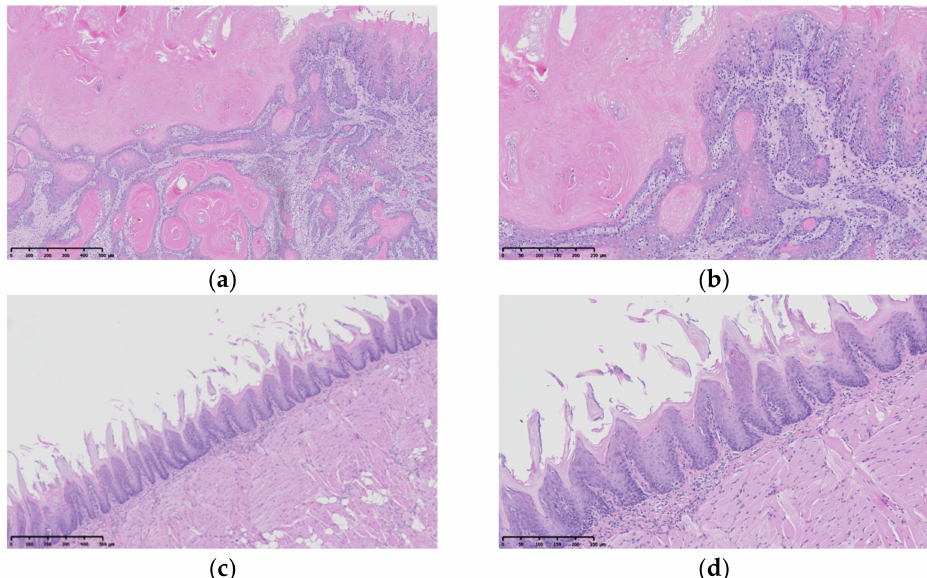
Figure 9. Histopathological assessments of tongues following H&E staining: ( a ) CTRL group (Mic. Mag.; × 100); ( b ) CTRL group (Mic. Mag.; × 200); ( c ) Film group (Mic. Mag.; × 100); ( d ) Film group (Mic. Mag.; × 200).